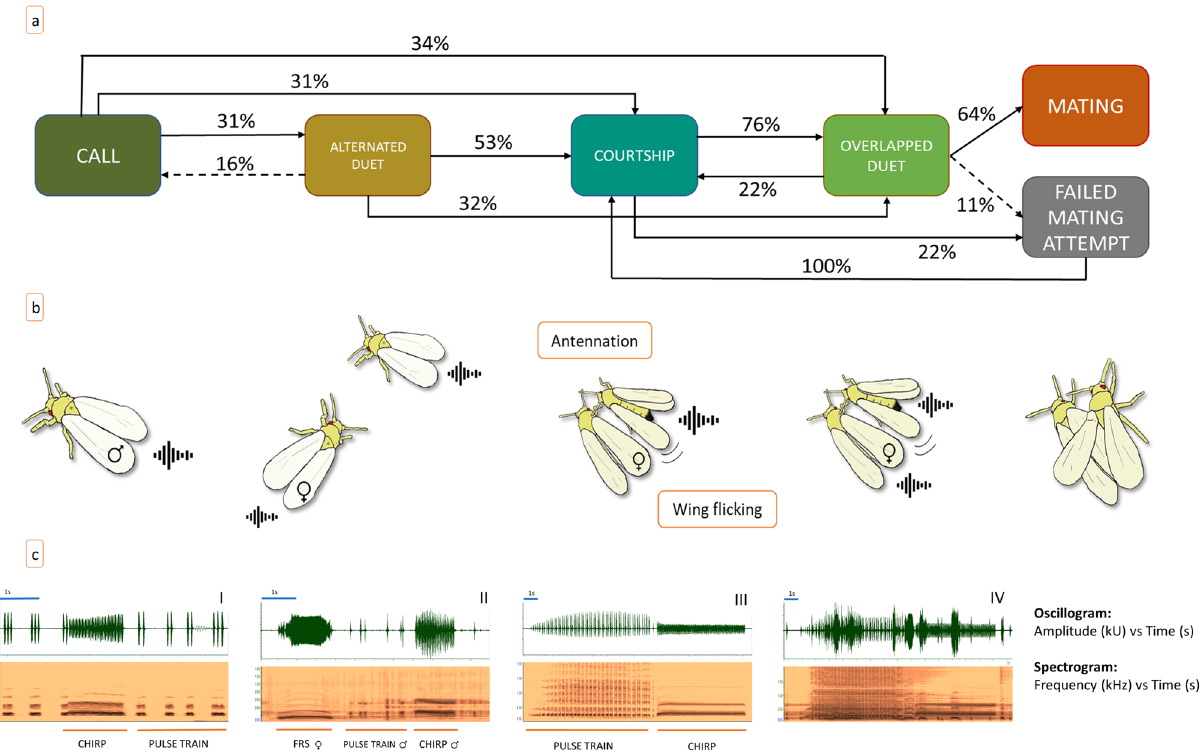
Figure 1. ( a ) Ethogram describing transition probabilities between behaviours that compose the process of pair formation in the greenhouse whitefly. Dashed lines represent no significant transitions ( P > 0.05), whereas solid lines are significant transitions ( P < 0.05). The percentage of observed transitions is indicated over each line. No significant transitions with percentages < 10% were not included in the ethogram; ( b ) A sequence of stereotyped mating behaviour in the greenhouse whitefly (author Sabina Avosani); ( c ) Oscillogram (above) and spectrogram (below) of GW vibrational signals. In I) male chirp and PT in call stage, II) male chirp and PT followed by FRS in alternated duet stage, III) male chirp and PT in courtship stage, IV) male chirp and PT overlapped by FRS in overlapped duet.